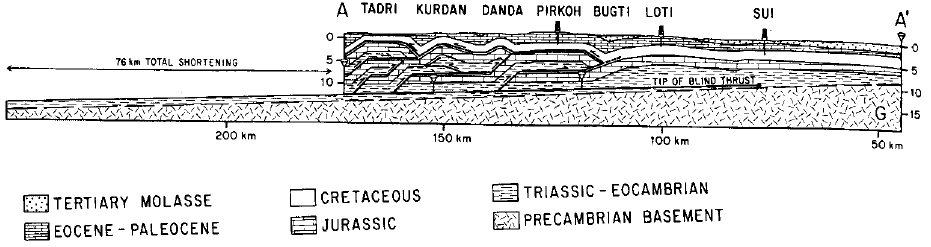
Fig. 2 –An antiformal stack over a basement slope of 2.5 ◦ and after shortening of 37%, in a balanced, NNW-SSE geological cross-section from the frontal Sulaiman fold belt of the Himalayan Mountain system in central Pakistan (after Jadoon et al. 1992).